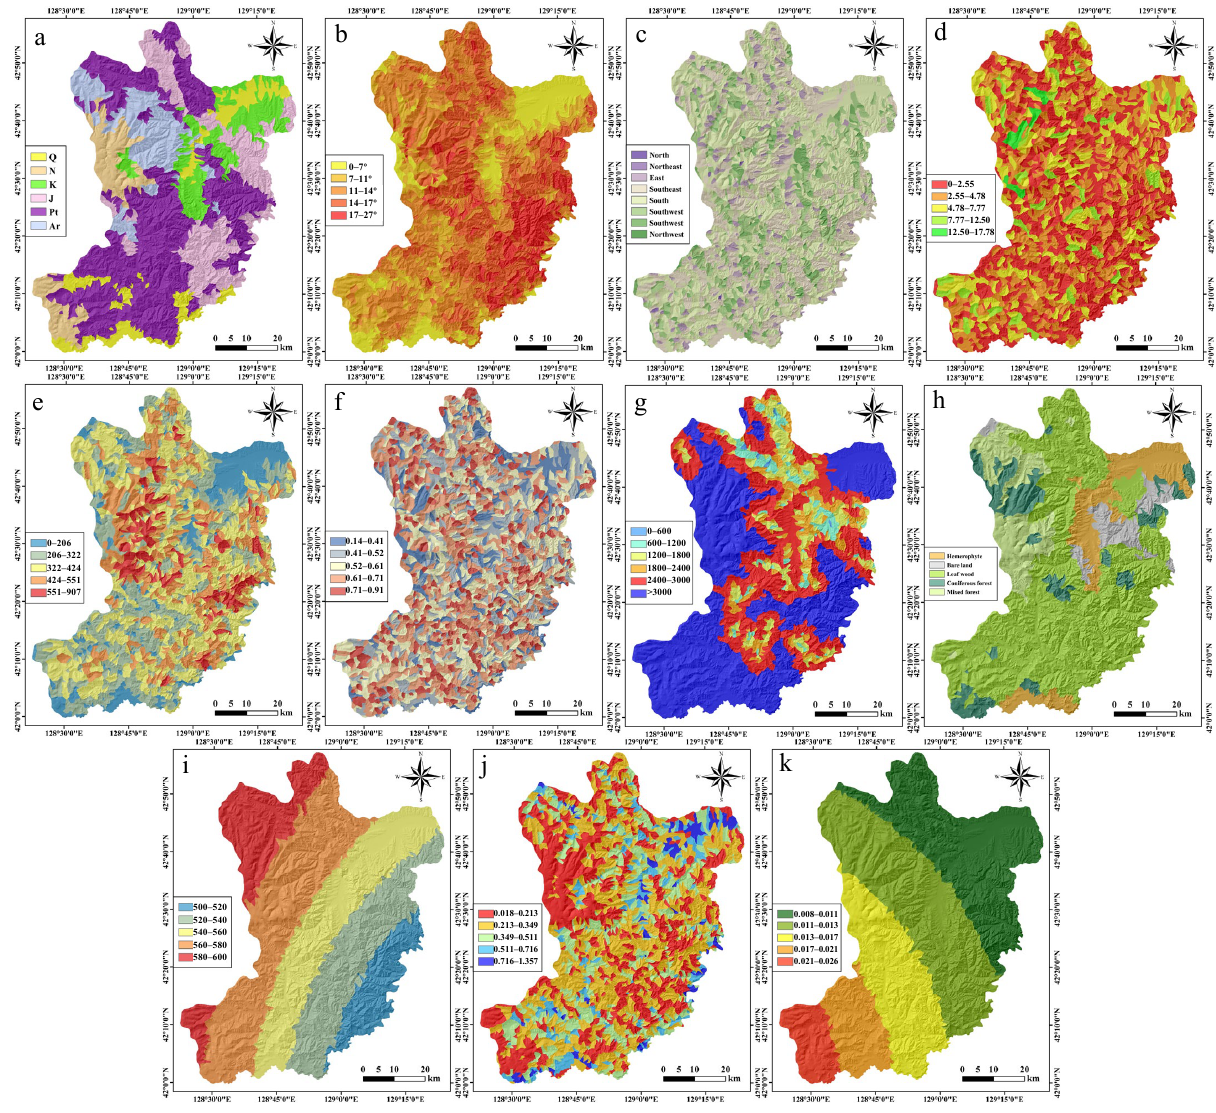
Figure 5. The conditioning factors for debris flow susceptibility mapping: ( a ) geology, ( b ) slope angle, ( c ) slope aspect, ( d ) area, ( e ) basin elevation difference, ( f ) roundness, ( g ) distance to fault, ( h ) land use, ( i ) average annual rainfall, ( j ) geomorphic information entropy, and ( k ) volcanic earthquake.